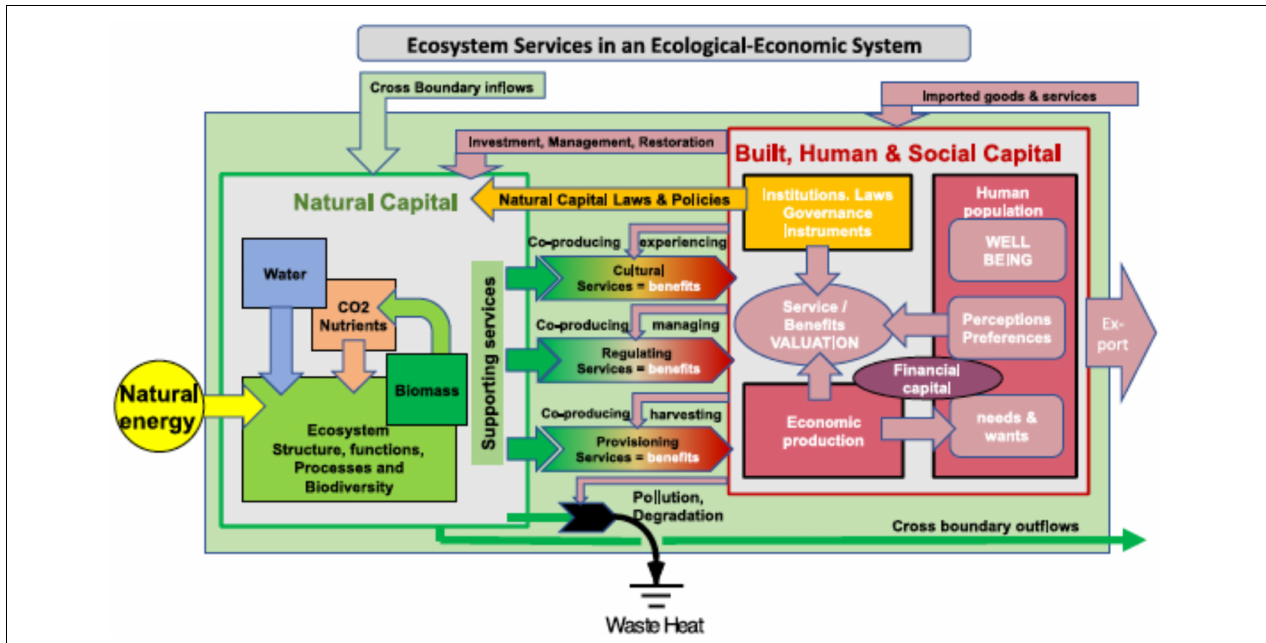
FIGURE 1 | Complex and dynamic interactions between natural capital and build, human, and social capital, which generate ES for enhancing human wellbeing (Costanza et al.,